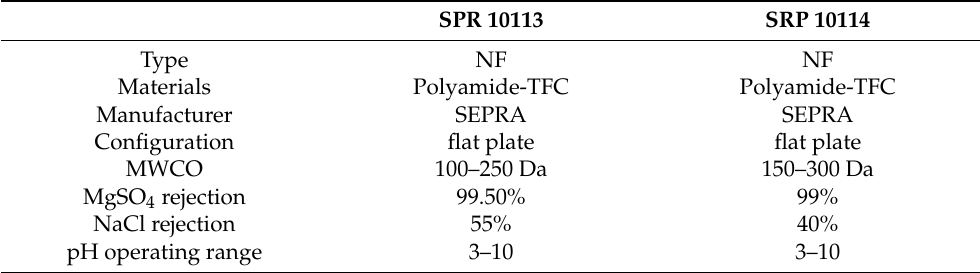
Table 1. Main NF membranes characteristics used for the treatment of F-contaminated waters.